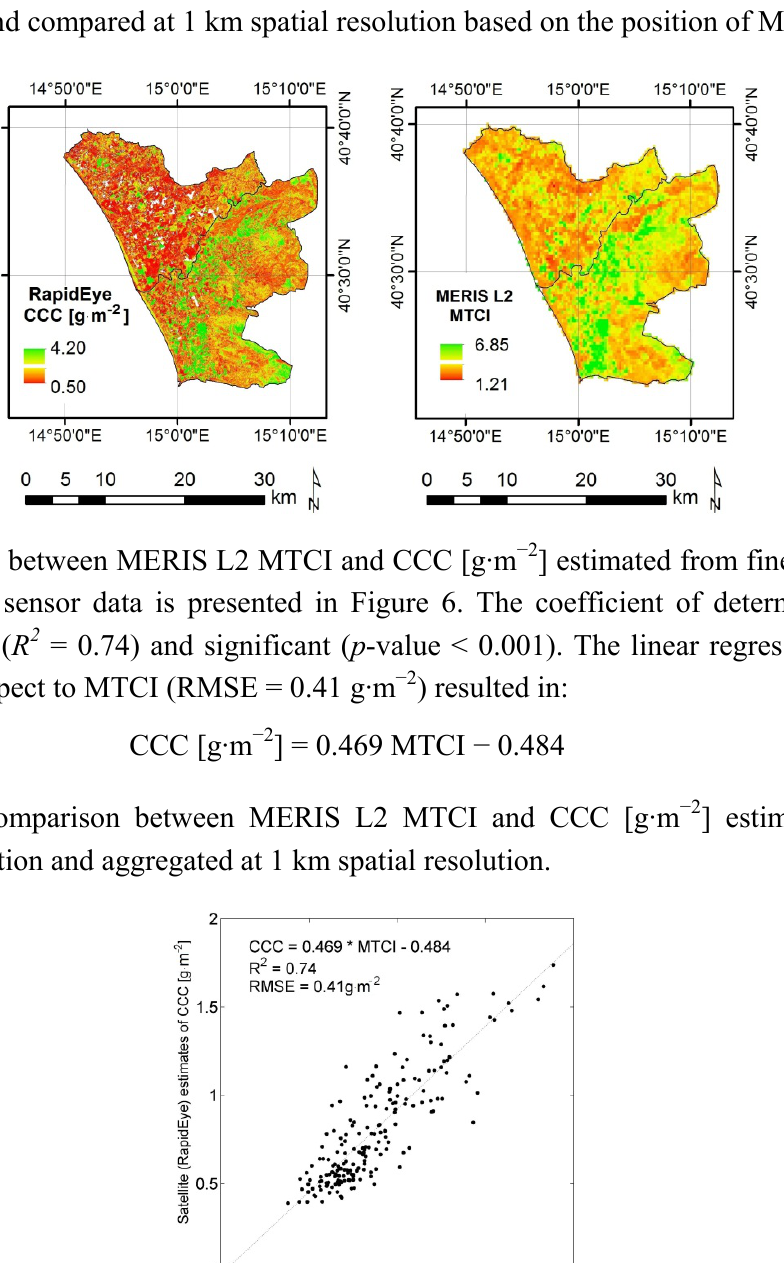
Figure 5. Fine spatial resolution CCC [g·m − 2 ] map from RapidEye satellite sensor data ( left ) and medium spatial resolution MERIS L2 MTCI data ( right ). The two maps were aggregated and compared at 1 km spatial resolution based on the position of MERIS pixels.